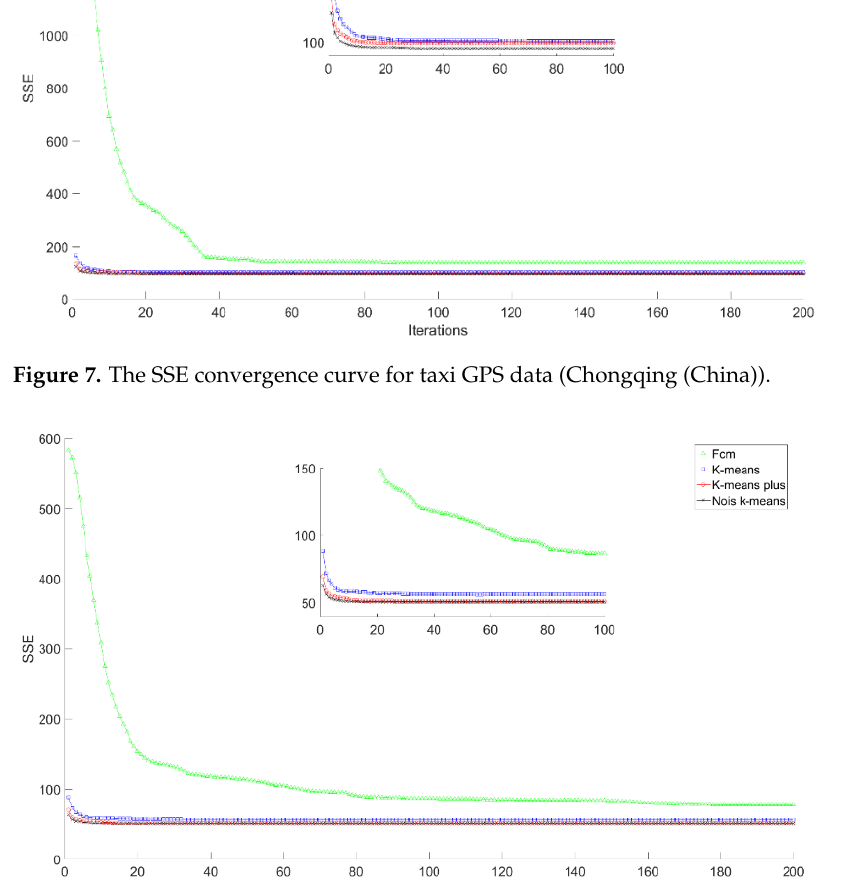
Figure 8. The SSE convergence curve for taxi GPS data (Beijing (China)).